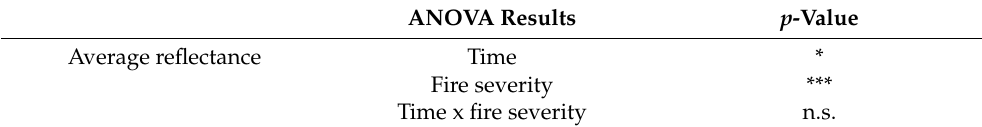
Table 4. Two-way ANOVA results. Significant differences at p < 0.05 *, and p < 0.001 ***. Abbreviation: not significant at a p < 0.05 (n.s.).